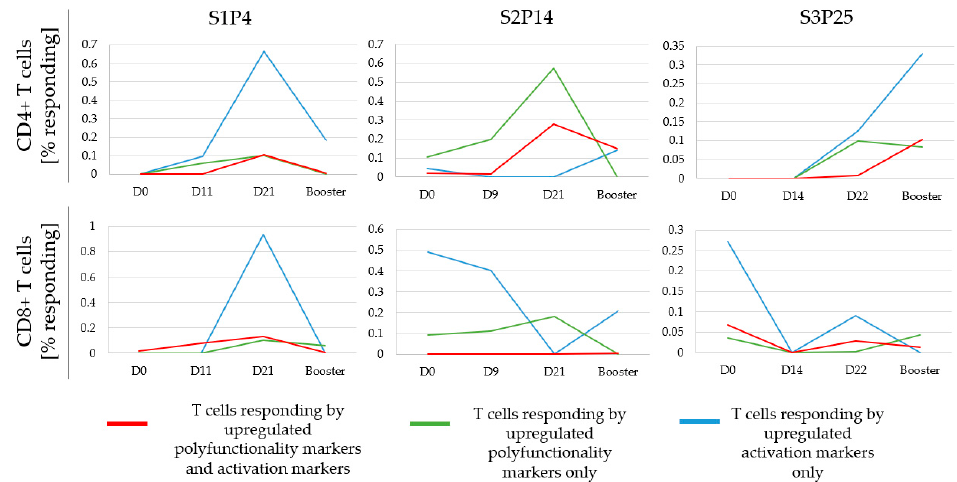
Figure 7. Effect of peptide vaccines and boosters on T-cell activation and functional responses. A glioma patient’s PBMC were cultured with or without peptides overnight, then stained and analyzed using the activation marker-inclusive FCM (A-FCM) protocol. T cells were monitored for early activation markers (4-1BB and CD40L) and for polyfunctionality (IFN γ and/or degranulation-CD107a). Shown are CD4+ helper T-cell (Th) and CD8+ cytotoxic T-cell (CTL) response dynamics for three representative peptides, one from each set.